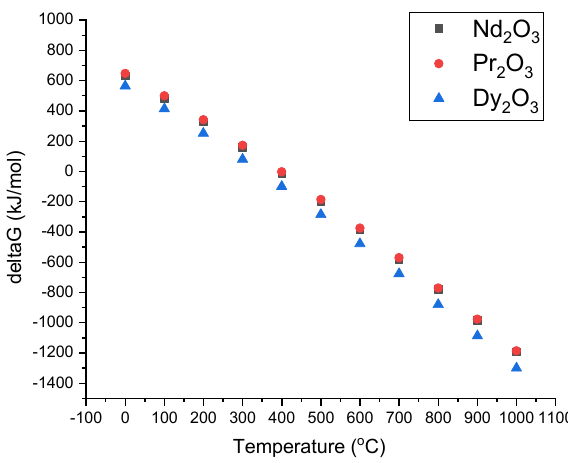
Figure 6. Gibbs free energy change depending on reaction temperature.